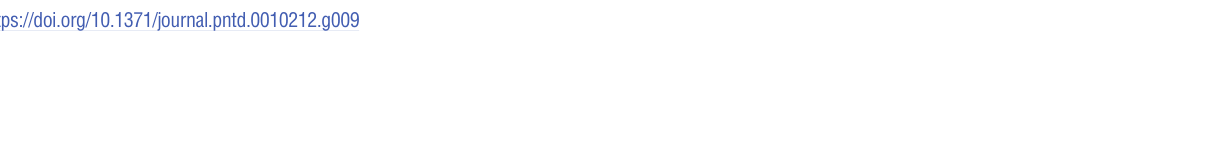
PLOS NeglectedTropical Diseases | https://doi.org/10.1371/journal.pntd.0010212 February 16,